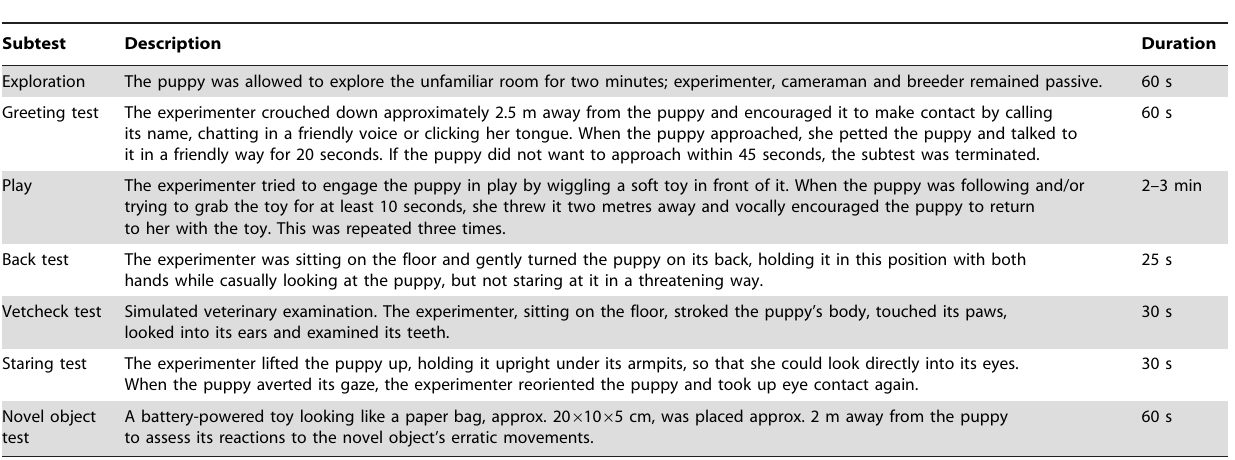
Table 3. Summary of the subtests of the puppy test that were used for